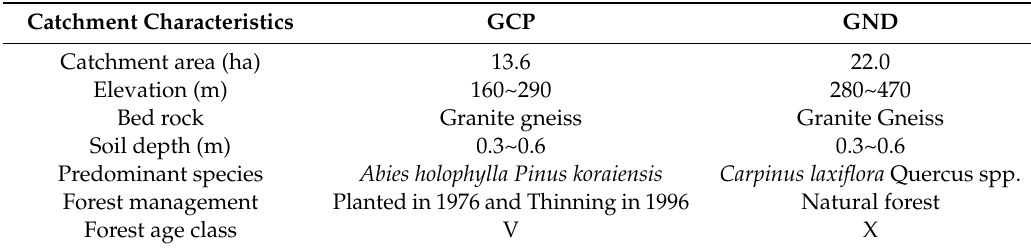
Table 1. Characteristics of the Gwangneung coniferous plantation (GCP) and natural deciduous (GND) forest catchments.